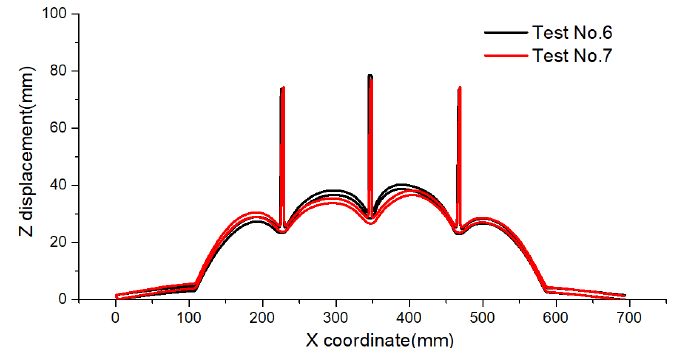
Figure 18. Central H-H section profile of Tests No. 6 and 7.